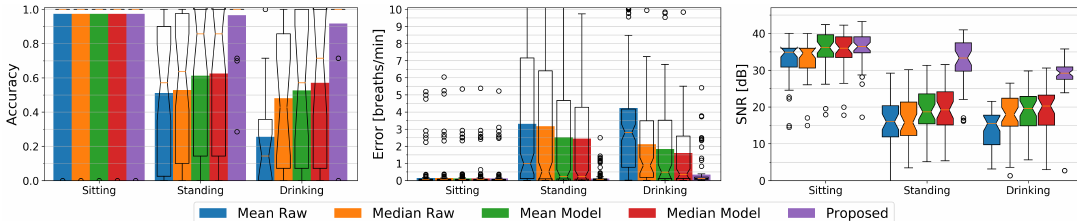
Figure 10. Left : The respiration rate accuracies of the chest using a Fast Fourier Transform window with a length of 48 s, for all participants performing three activities (sitting, standing upright, and drinking), for the following methods: Mean Raw, Median Raw, Mean Model, Median Model, and our proposed method. The colored bars show the averages, while overlay box plots show median (middle parts) and whiskers marking data within 1.5 IQR. Middle : The error in breaths per minute of the different methods again using bars and overlay box plots. Right : The signal to noise ratio (or SNR) of the chest area shows a similar picture to the accuracy performance measures: Sitting results for all methods in a much clearer signal than standing upright, with standing and occlusion (holding a cup, right measures) performing slightly worse than just standing